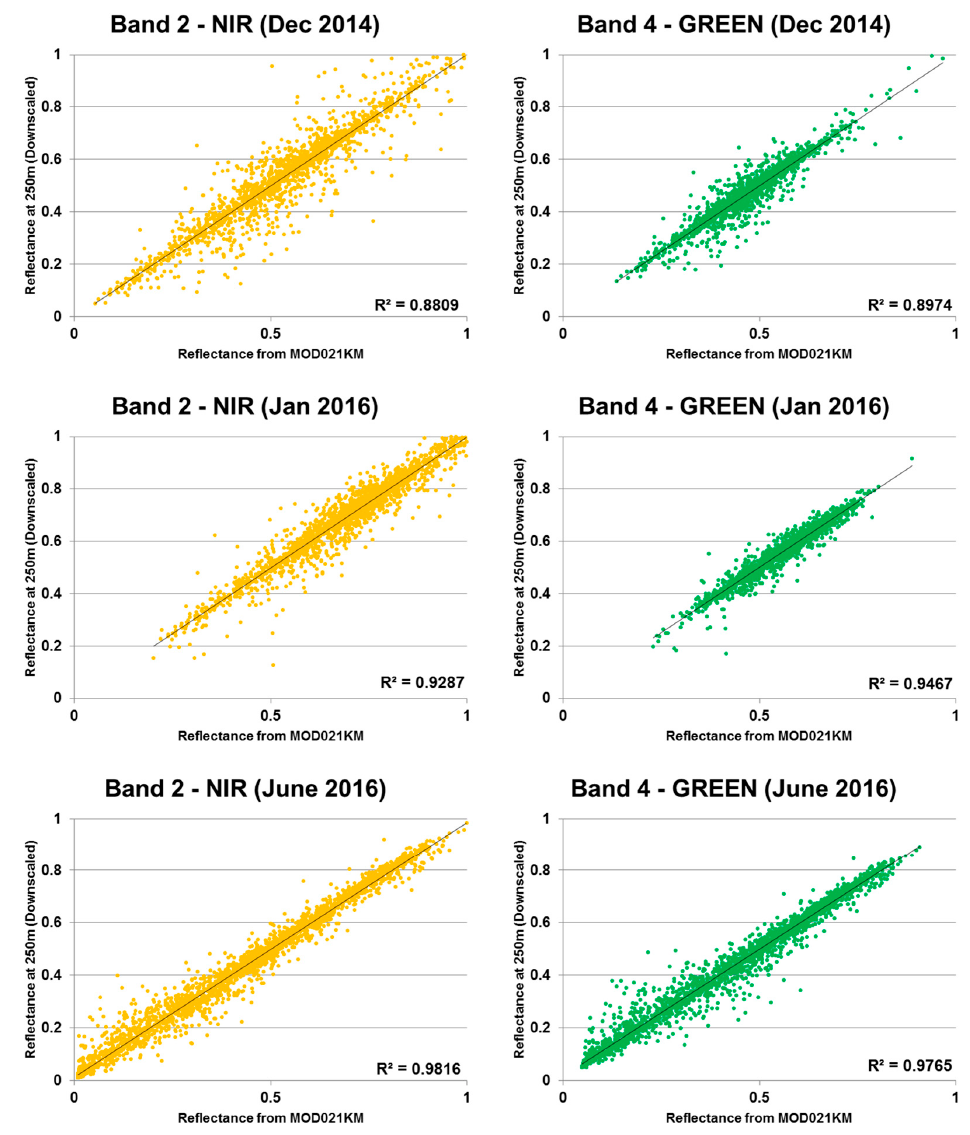
Figure 11. Agreement between the TOA reflectances of the MOD021KM Bands 2 and 4 and the downscaled bands at 250 m grid resolution generated by the CCRS algorithm for 3 different scenes during freeze-up, stable cover, and melt periods.